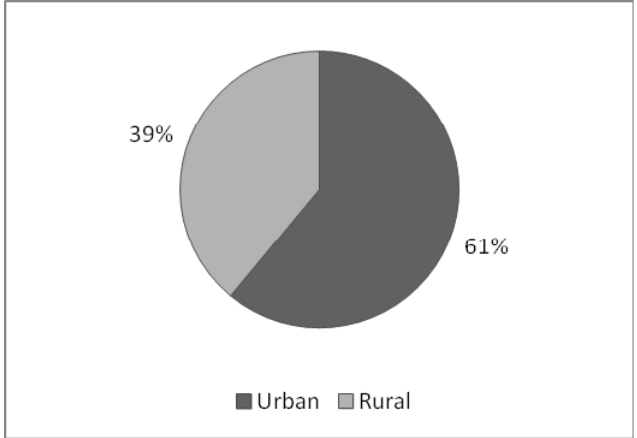
Figure 8. São Tomé: population distribution in accordance with urban and rural areas